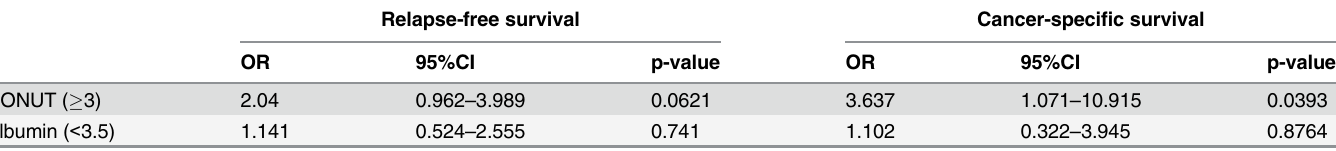
Table 7. The results of the multivariate analysis of the association between the CONUT score and the albumin level with relapse-free survival and cancer-specific survival. Relapse-free survival